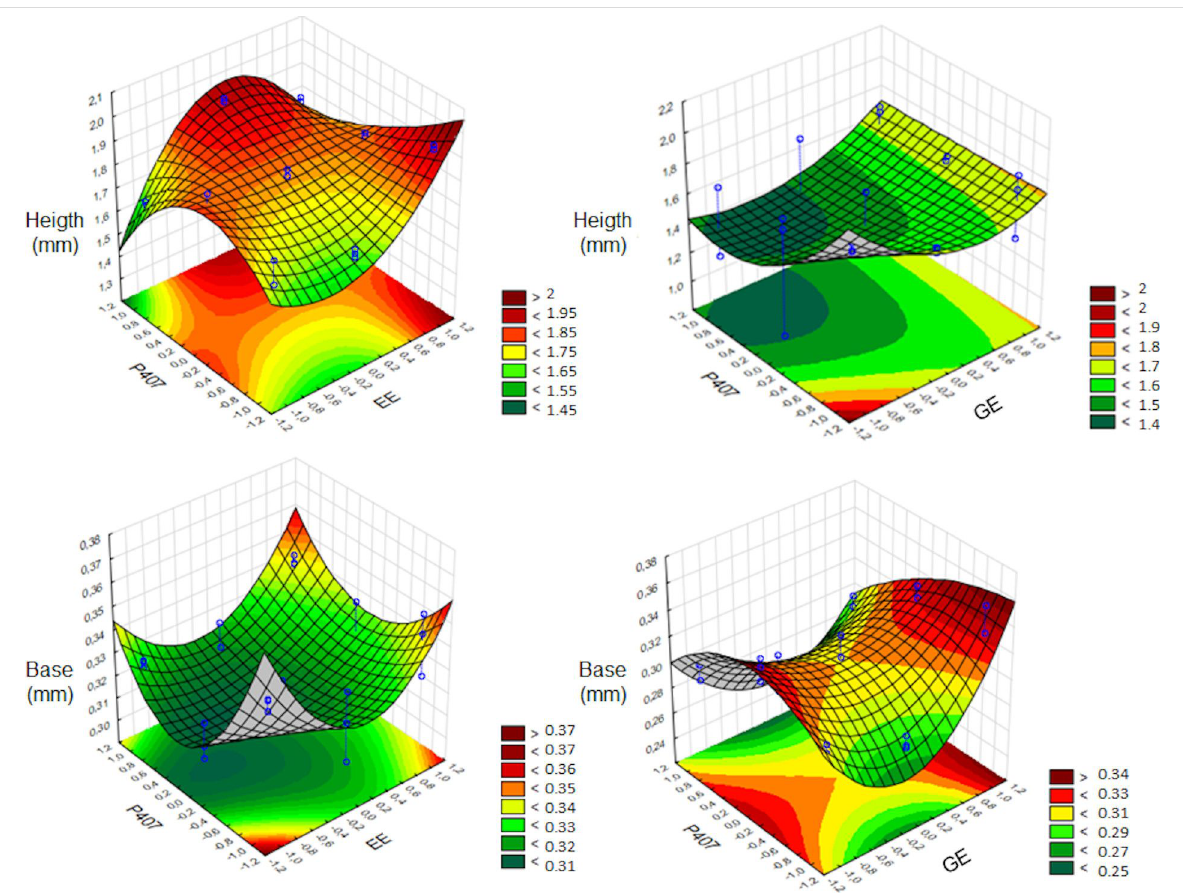
Figure 5: Response surface plots for height and base measurements of MNs containing EE or GE. The color scale is indicated in each figure and shows the isoparametric values.